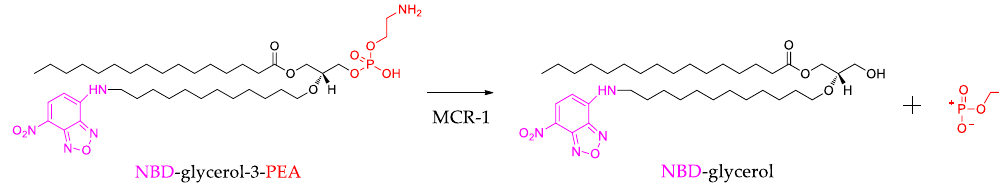
Figure 3. The scheme for the enzymatic reaction catalyzed by the MCR-1 protein.